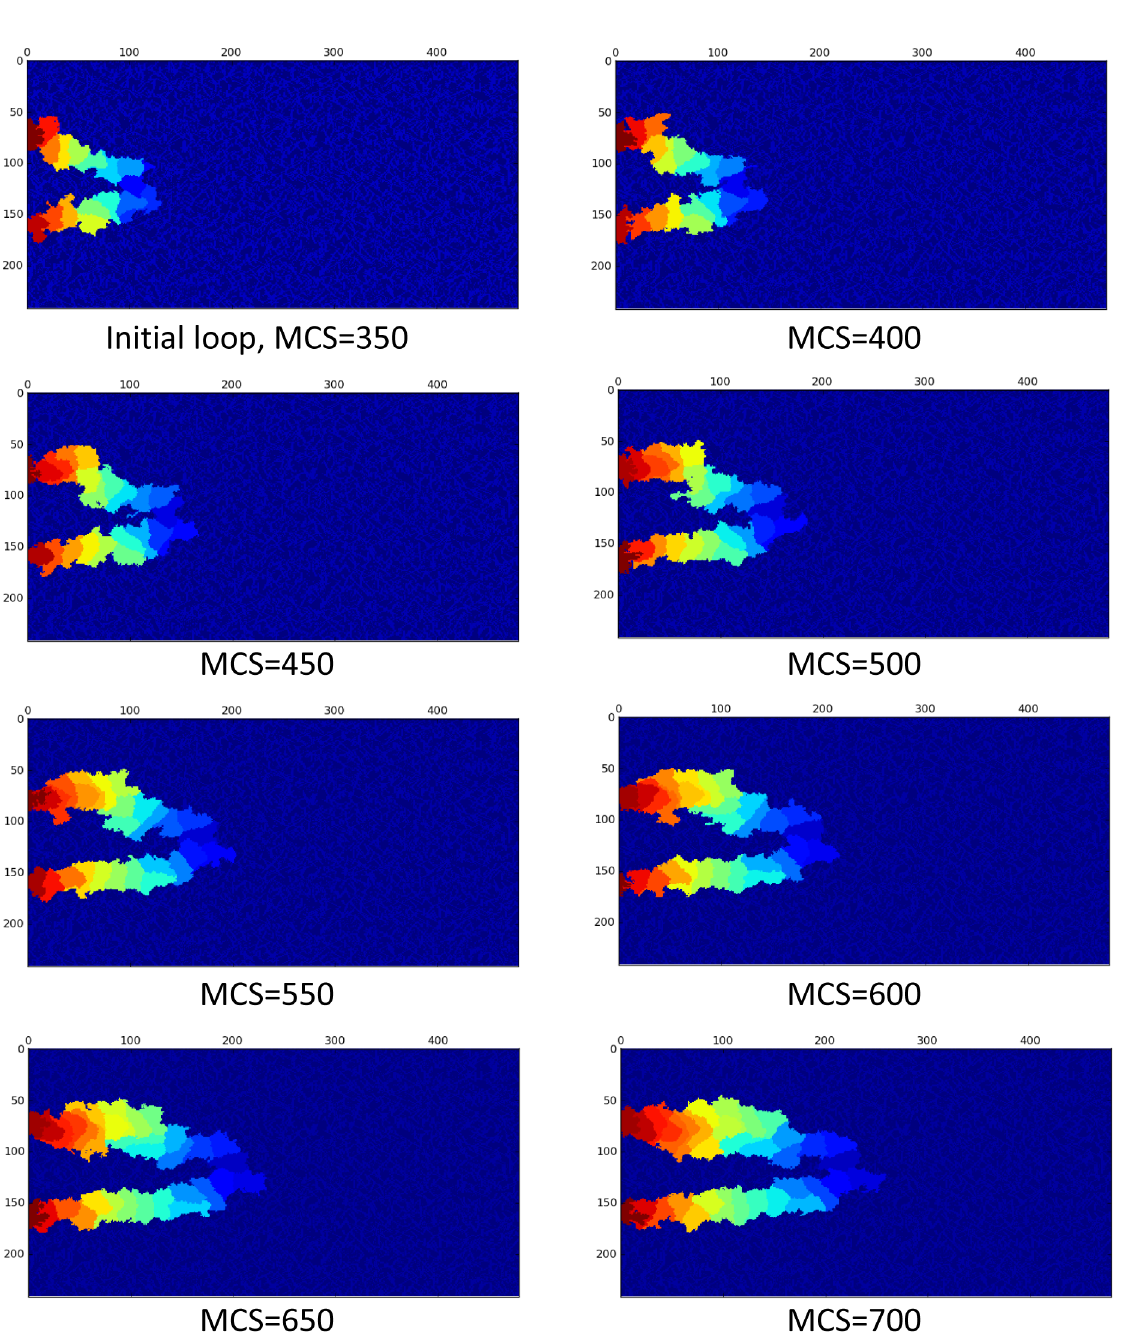
Fig 12. Survival of loop when both proliferation and migration signals are activated by flow in the loop. EC color is representative of their identity in the solution. The X and Y-axis show the domain size in μ m.